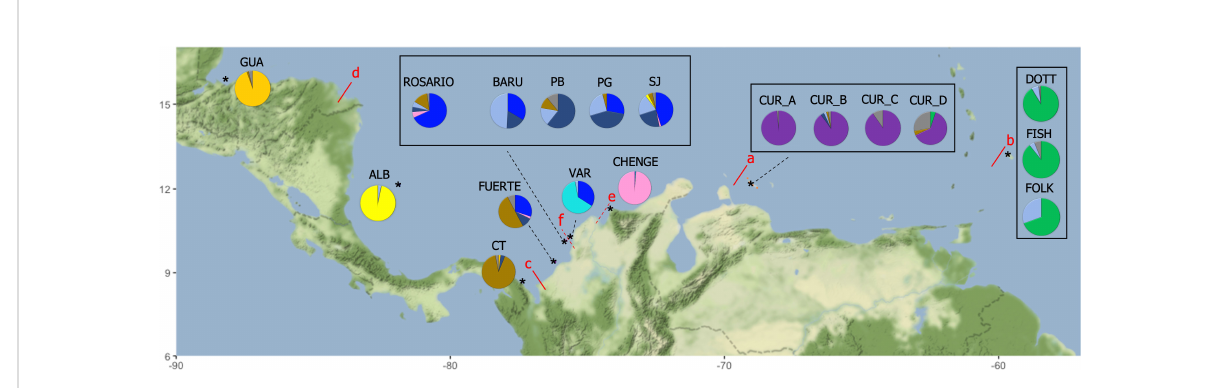
FIGURE 2 Percentage of individuals assigned to each of the 11 clusters (pie frequency charts). The colours were assigned following the result from STRUCTURE HARVESTER. The red lines illustrate the disruptions (barriers) detected by BARRIER ranked from “ a ” to “ f ” in order of importance. The symbol * means an approximated location of sampling.